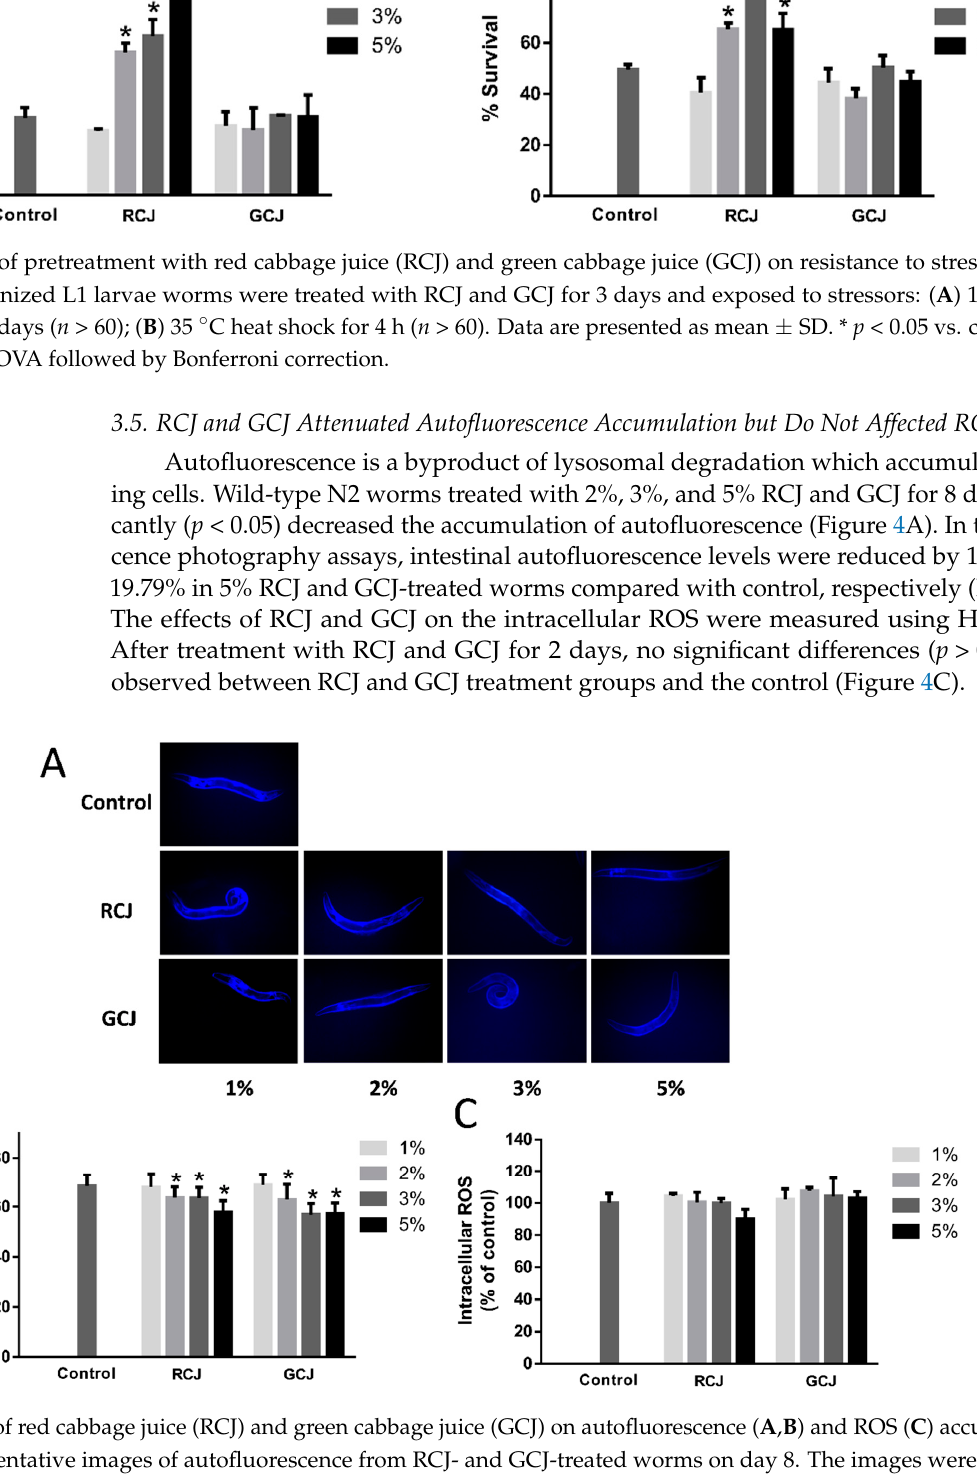
alive, respectively (Figure 3A), suggesting that RCJ supplementation enhanced resistance